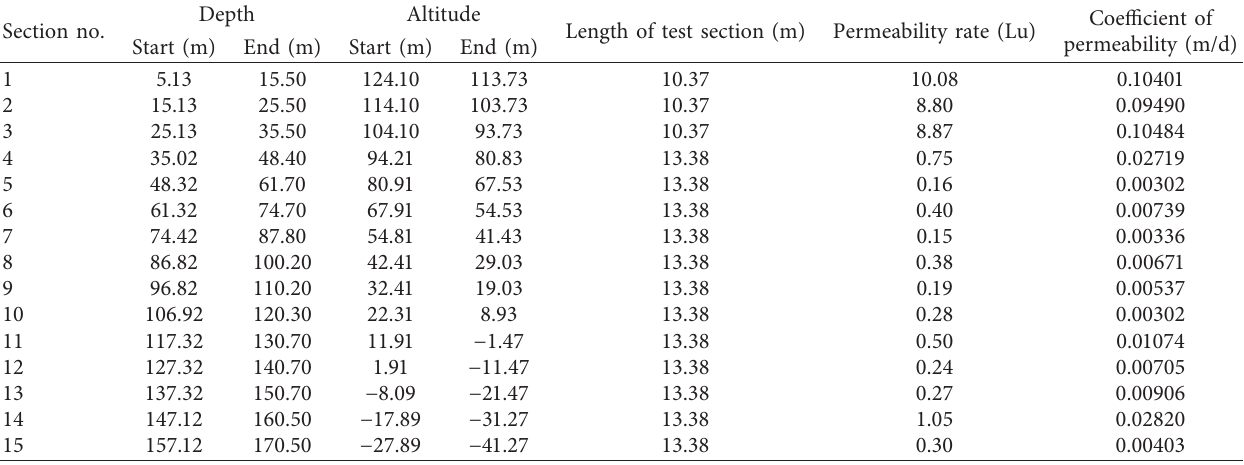
Table 1: The results of water pressure tests in the borehole.